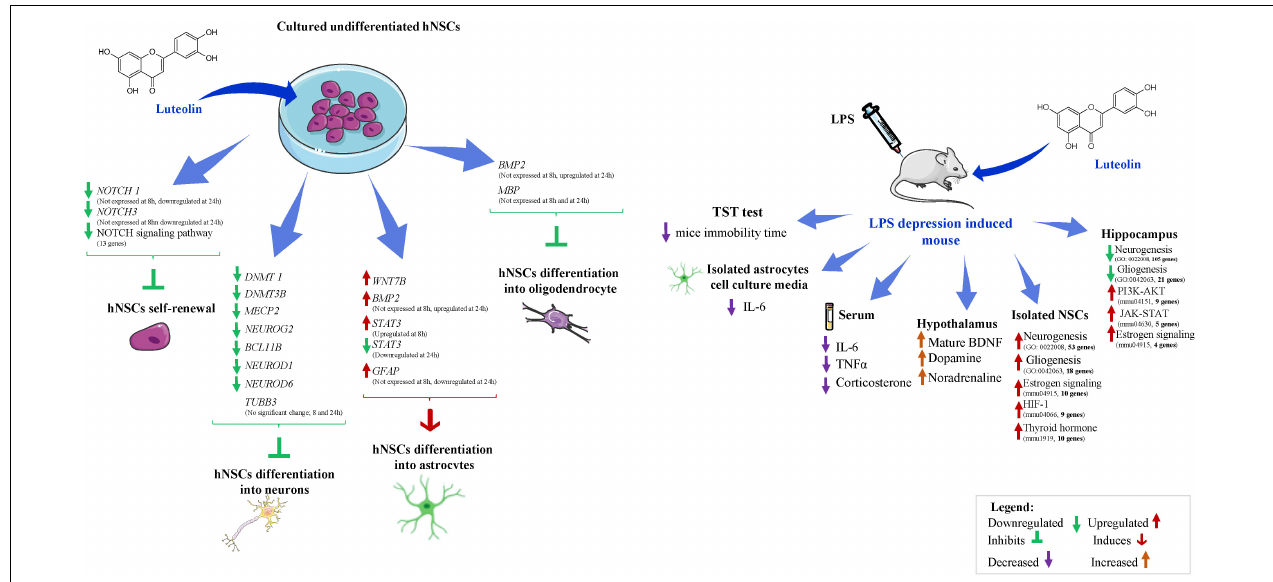
FIGURE 6 | Schematic diagram of the effects of luteolin on human neural stem cells and on LPS-induced depression mice. Images are downloaded from